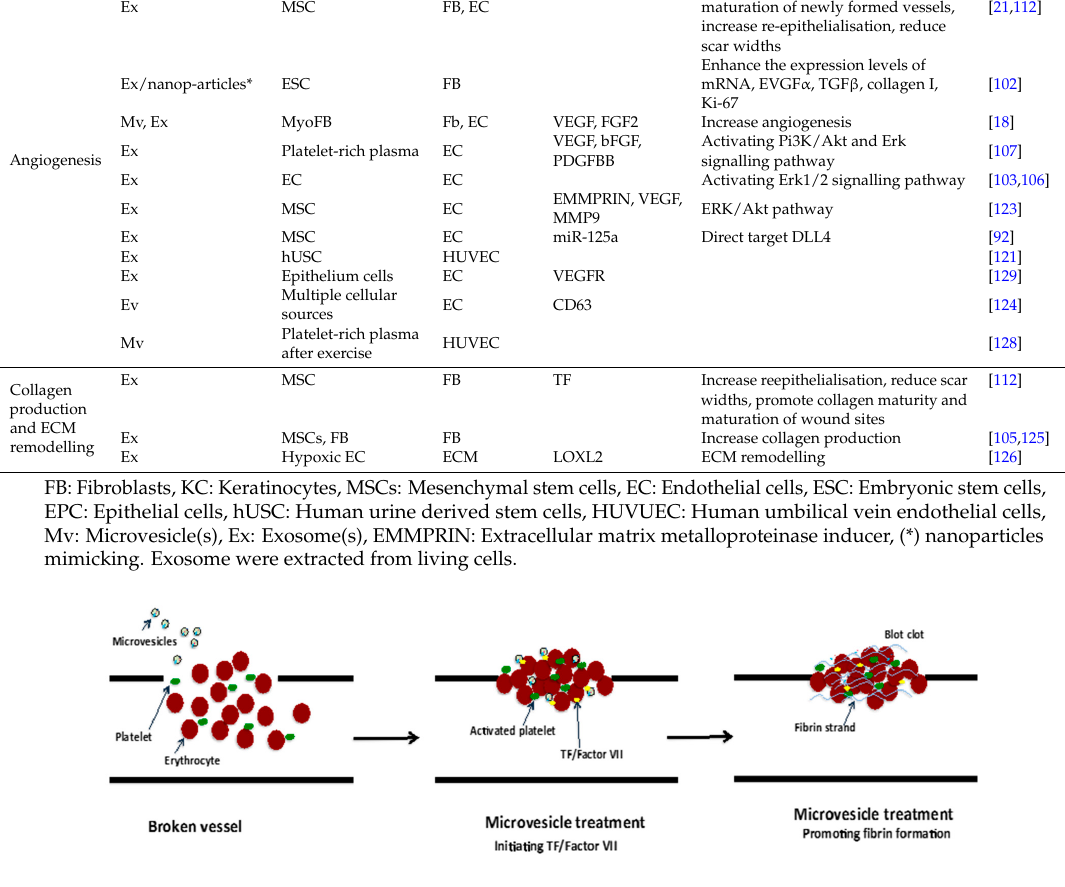
Figure 6. Promotion of coagulation by TF-barring microvesicle treatment. Rapid coagulation is triggered by the initiating TF/Factor VII and promotion of fibrin strand formation [98,99]. Int. J. Mol. Sci. 2017 , 18 , 956